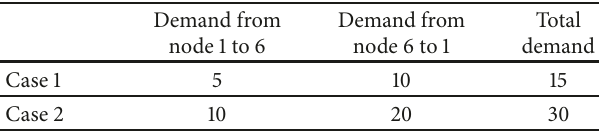
Table 2: Travel demand